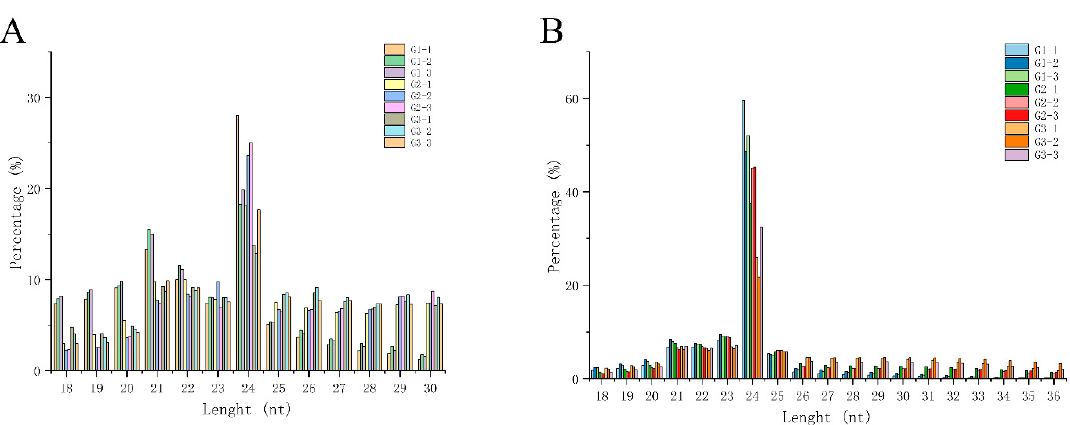
Figure 4. The length distribution of small RNA in the walnut kernel at different developmental stages. ( A ) Length distribution of clean reads. ( B ) Length distribution of unique reads.